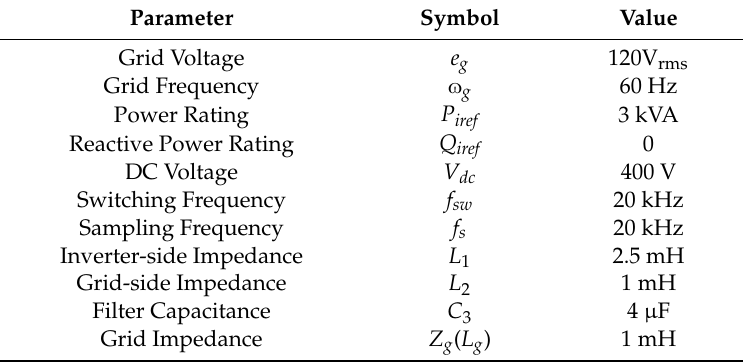
Table 1. System parameters of multi-parallel